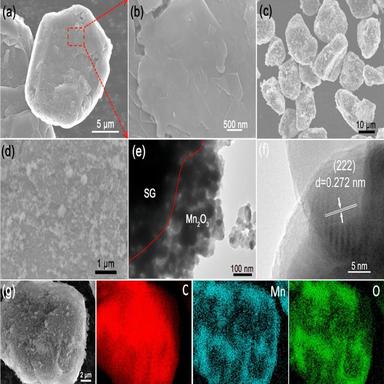
(a, b) SEM images of SG. (c, d) SEM images, (e, f) TEM and HRTEM images, (g) elemental mapping images of SG/Mn2O3-2 composite.